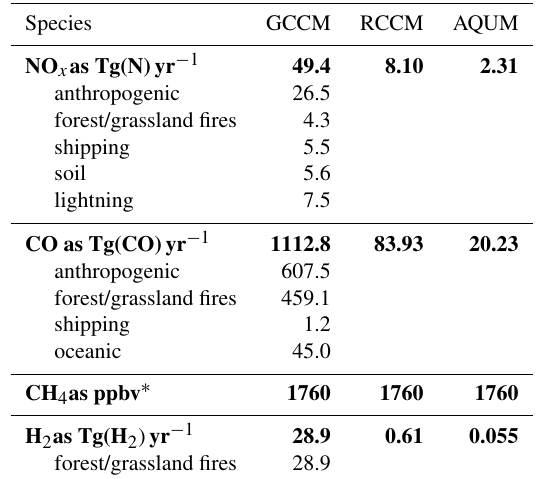
Table A2. Summary of the annual total emissions of trace gases used in the GCCM, RCCM, and AQUM models. Bold type shows the annual total for each